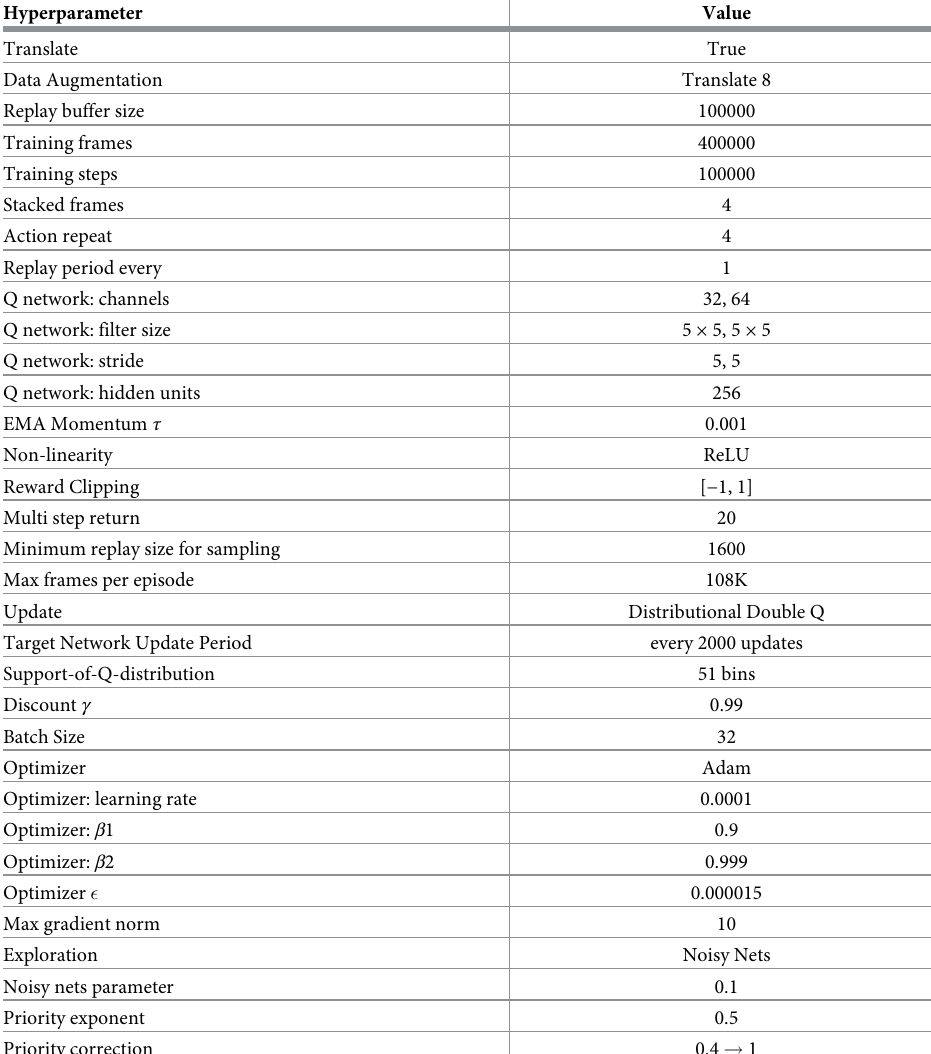
Table 1. Hyperparameters for Atari Games 100K.